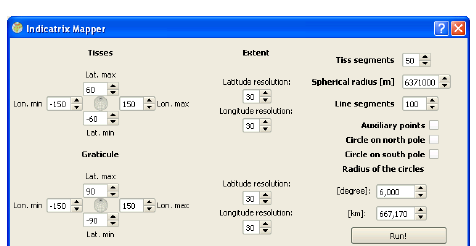
Fig. 13. The Puzzles of WebMercator (source: www.oshermaps.org/of-maps-and-history/ great-interactive-tool-to-teach-the-distortions-of-the- mercator-projection)